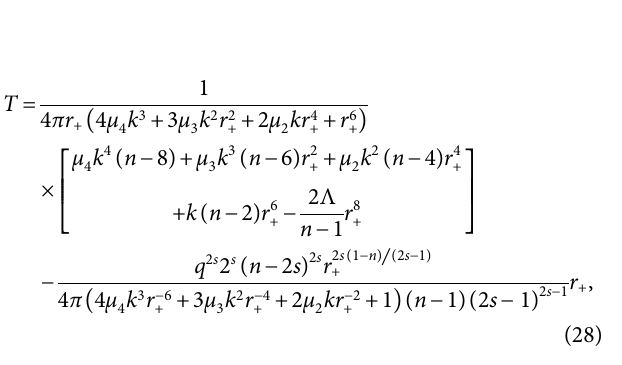
FIGURE 5 | Isenthalpic curves and inversion curve of the BI quasitopological black hole with (cid:5) μ 2 (cid:1) 0 . 1, (cid:5) μ 3 (cid:1) 0 . 1, (cid:5) μ 4 (cid:1) − 0 . 001, k (cid:1) − 1, Q (cid:1) 1, n (cid:1) 4 and β (cid:1) 20.